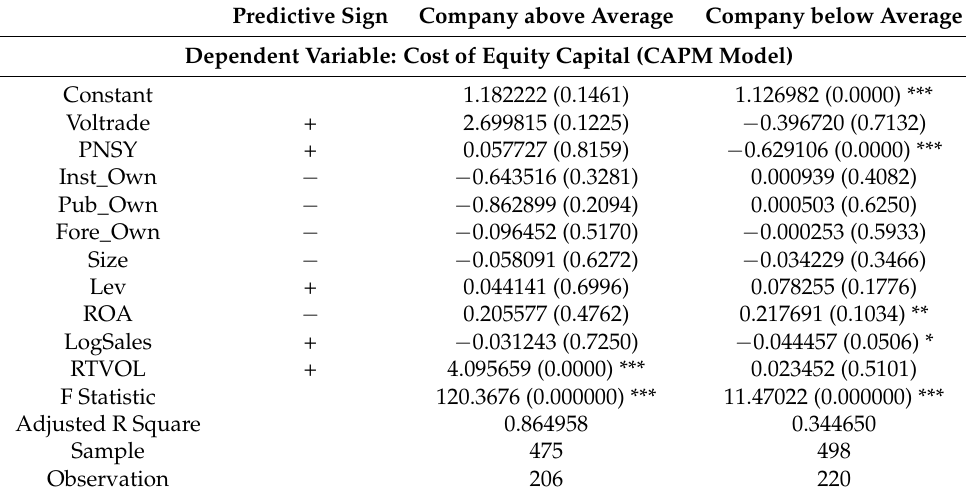
Table 6. Additional testing based on the size of the